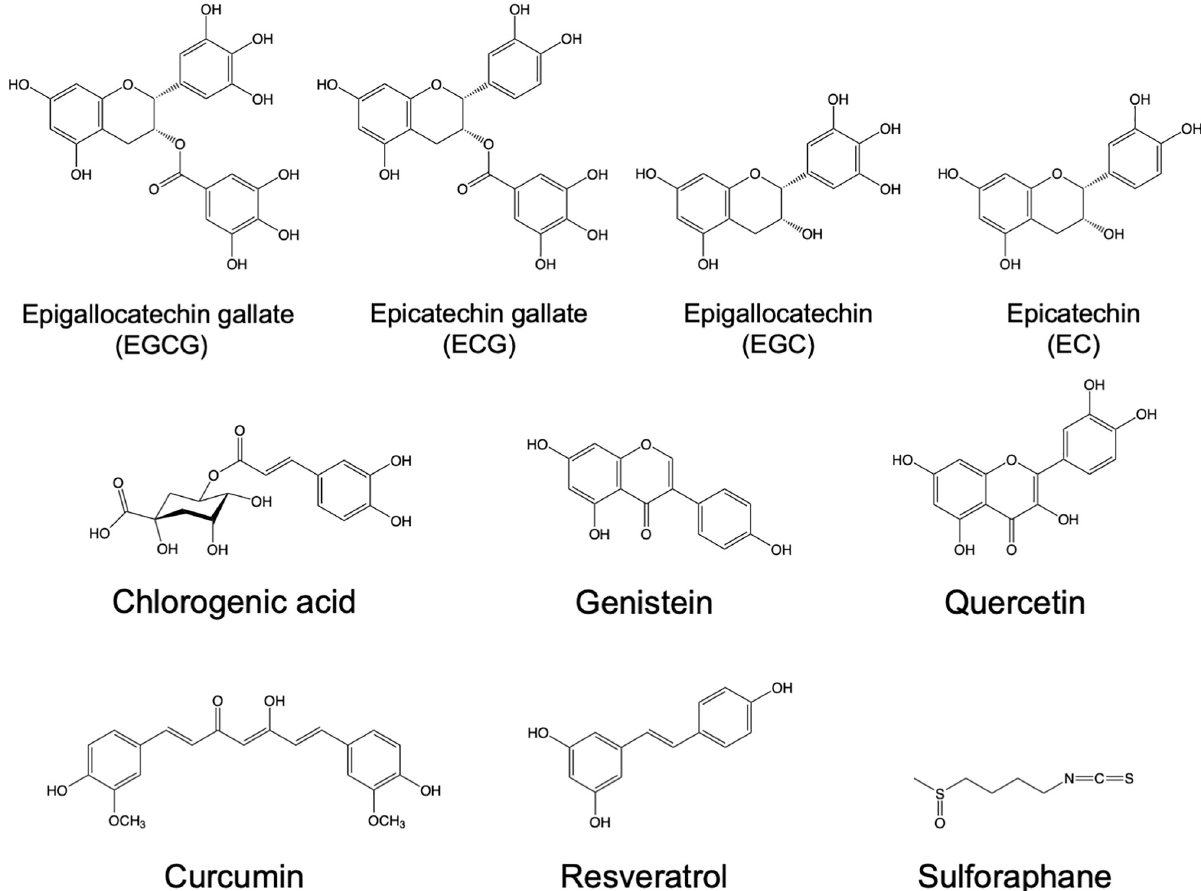
Fig 1. Chemical structures of phytochemicals. 1: Epigallocatechin gallate (EGCG); 2: epigallocatechin (EGC); 3: epicatechin gallate (ECG); 4: epicatechin (EC); 5: chlorogenic acid; 6: genistein; 7: quercetin; 8: curcumin; 9: resveratrol; 10: sulforaphane.